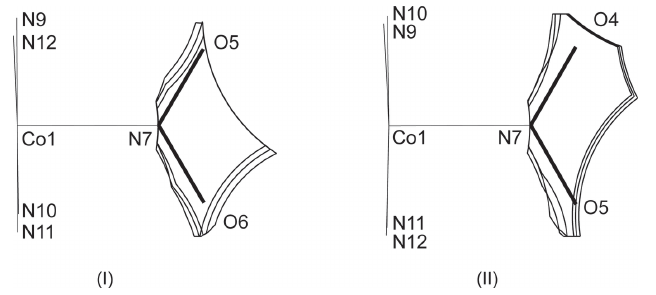
Figure 8 Comparison of the slices of the cavity around the nitro group within 0.1 A˚ from the plane in (I) and (II).